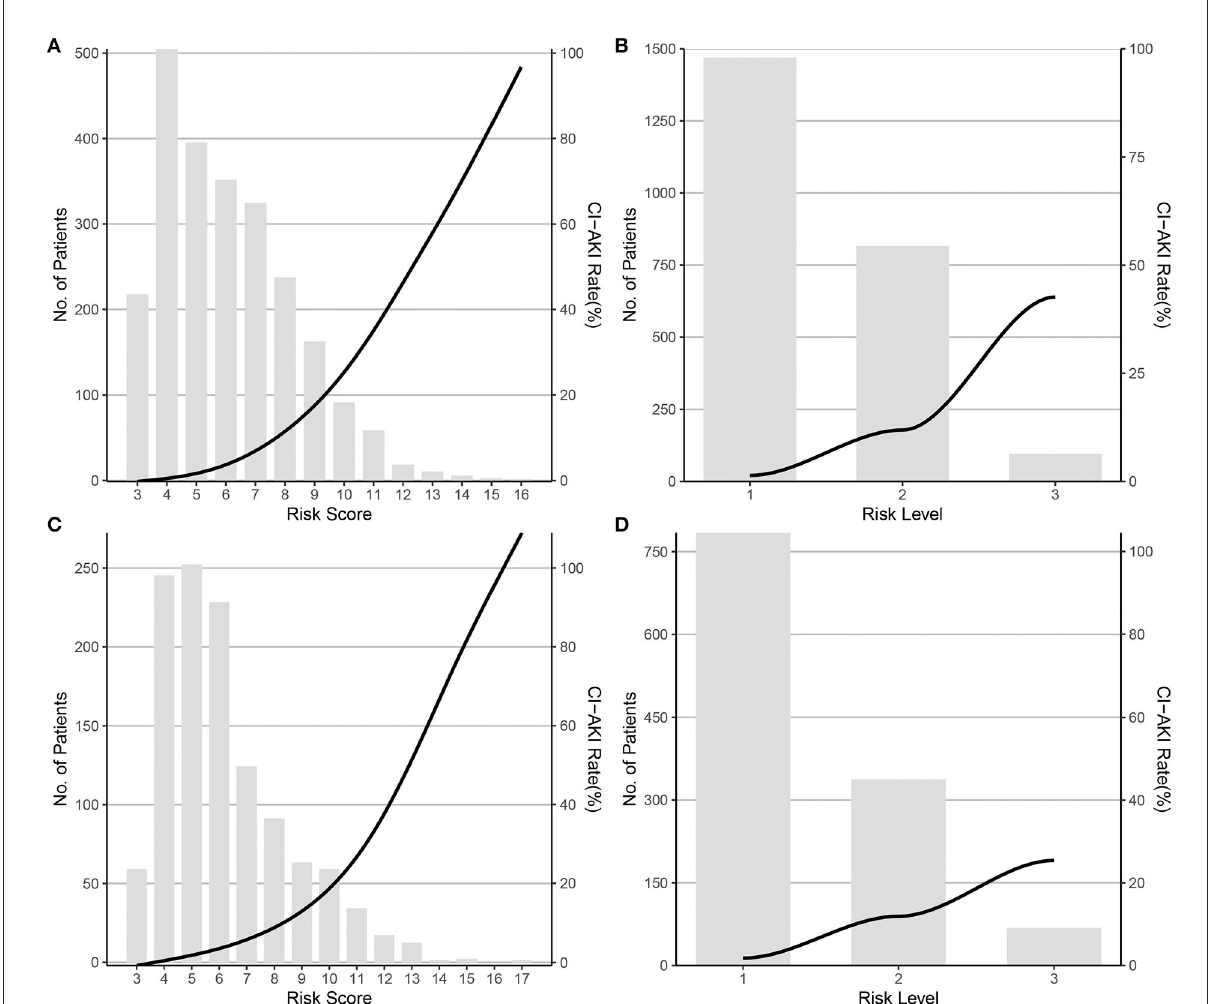
FIGURE1 CI-AKI rate by risk score and risk level in the derivation and validation cohort. (A) By risk score in the derivation cohort; (B) By risk level in the derivation cohort; (C) By risk score in the validation cohort; (D) By risk level in the validation cohort. CI-AKI, contrast-induced acute kidney